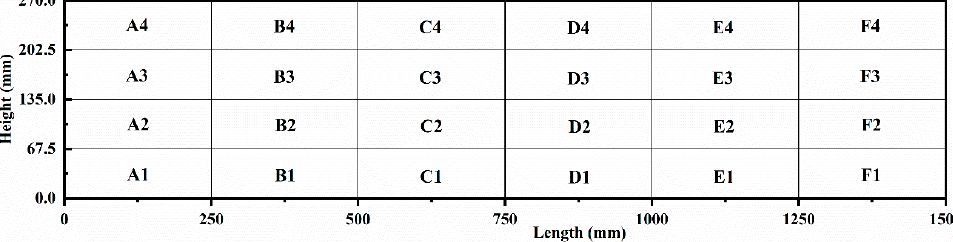
Figure 3. The region codes of the channel for particle size analysis.